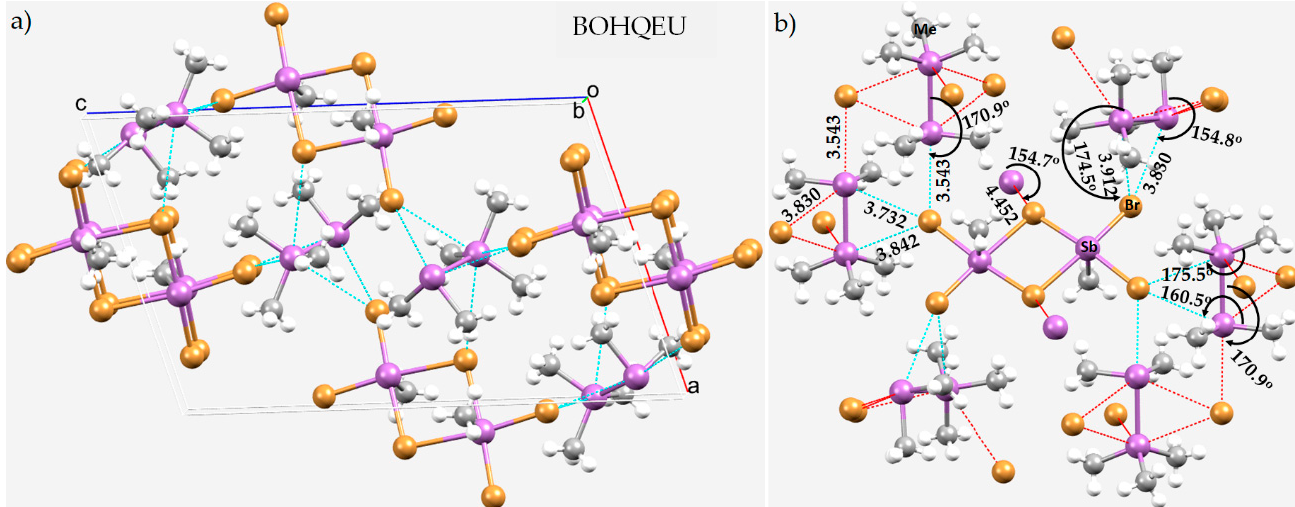
Figure 12. ( a ) The unit-cell of the crystal of (trimethyl-stibino)-dimethyl-stibonium hexabromo-dimethyl-di-antimonate(III), [(CH 3 ) 3 Sb ‒ Sb(CH 3 ) 2 ] 2 [(CH 3 SbBr 3 ) 2 ], showing Sb···Br interactions. ( b ) Illustration of the nature of Sb-centered non-covalent interactions (dotted lines in cyan) in the crystal. Selected bond lengths and bond angles in Å and degree, respectively are shown. Hanging contacts between atoms are shown as dotted lines in red. The CSD ref. code is shown.